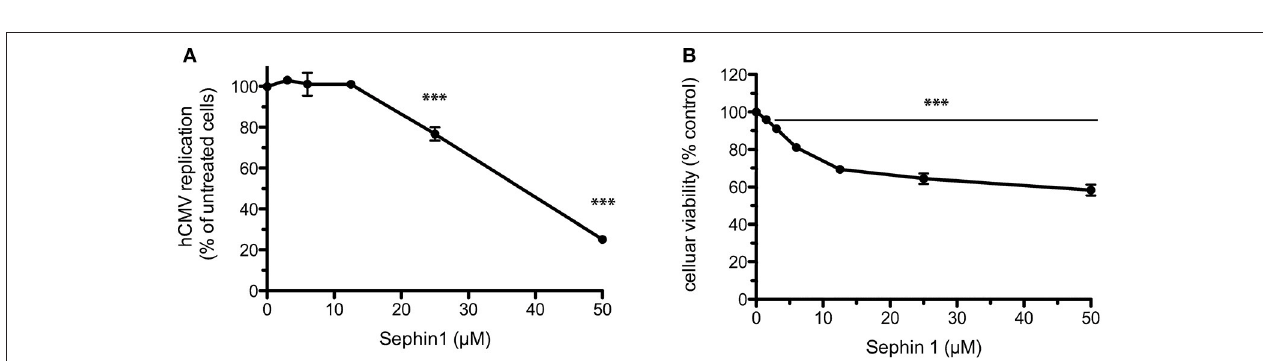
FIGURE 8 | Evaluation of the antiviral properties of Sephin1 against myxoma virus. (A) RK13 cells were infected with myxoma virus and incubated in the presence of 50 µ M Sephin1 or DMSO alone (control). Viral titers were determined from crude lysates harvested at the indicated times post-infection. (B) Viability of RK13 cells incubated with increasing doses of Sephin1 or DMSO alone was determined after 24h incubation using the cellular viability assay Vita-Blue. Data represent mean ± SEM from representative experiments, repeated at least three times. ** p < 0.001, *** p < 0.001 by one-way analysis of variance, followed by Bonferroni comparison test comparing the Sephin1-treated groups at the indicated concentrations to the vehicle-treated control group.